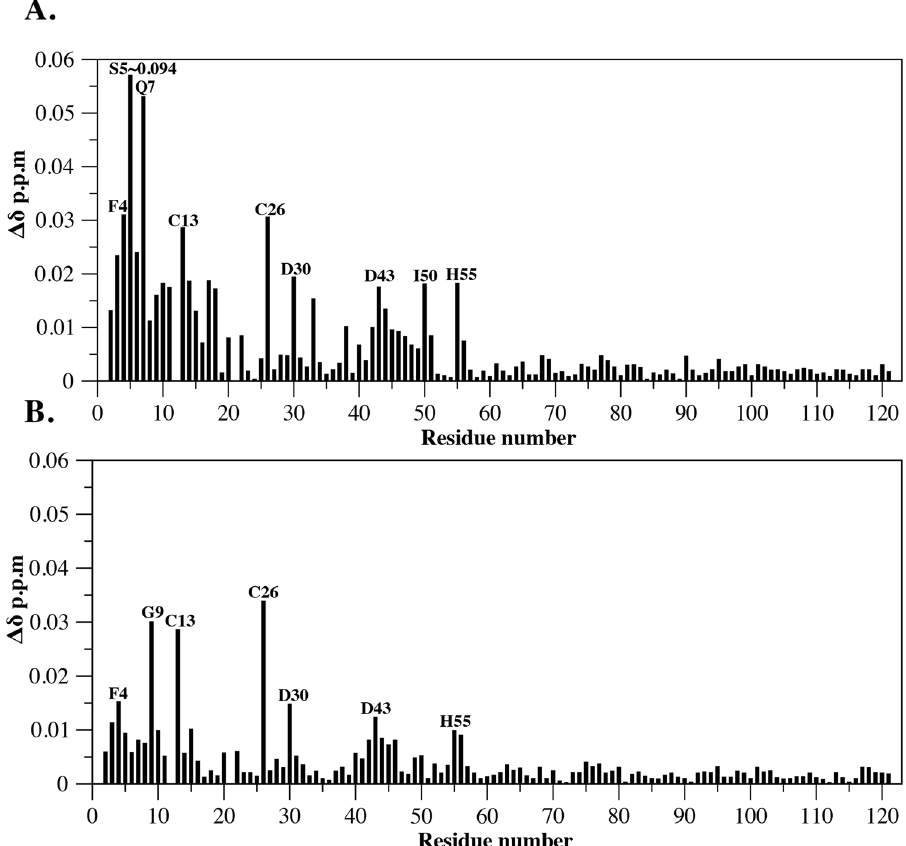
Figure 6. Plot of the change in average 1 HN and 15 N chemical shifts following titration of 15 N-RXFP2 (1–65) P4F with 20 equivalents of ( A ) ssRXFP1 and ( B )